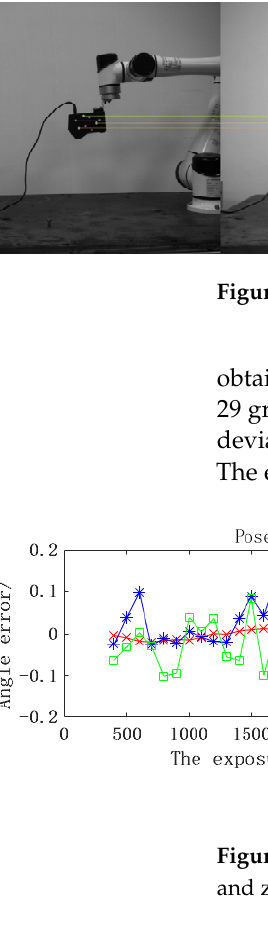
(20) Figure 13. Left camera images at distances of 1.2 m and 2.3 m. As can be seen in Figure 14, the translation deviation of the positioning system is relatively stable within the range of 1.8 m, and the error is less than 0.50 mm. When the distance increases to 2.3 m, the translation error reaches 1.34 mm. The possible reason for this is that at a long distance, the size of the circular mark is too small to be easily identi- fied, resulting in a large error.